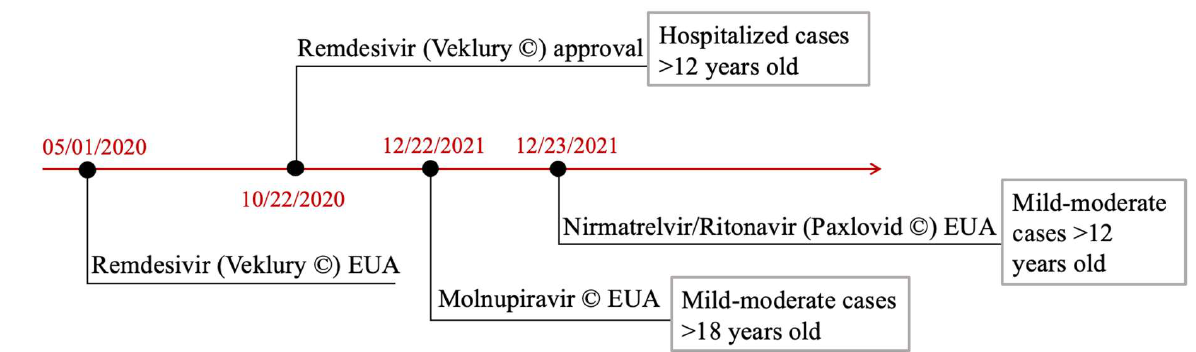
Figure 7. The lack of an established antiviral therapy has tempered the use of an EMB. The figure shows the most commonly used antivirals in patients with COVID-19, with or without the development of viral myocarditis, as well as the different times that led to their approval. The FDA’s and EUA’s process timeline for antiviral approval. Remdesivir (Veklury ® ) EUA’s process was definitively formalized in January 2020, and its definitive approval occurred in October 2020. Molnupinavir and Paxlovid ® EUA’s process followed in December 2021. In addition, gray-outlined boxes demonstrate the presented indications on the side of each authorized therapeutic agent. Abbreviations: FDA: Food and Drug Administration; EUA: Emergency Use Authorization